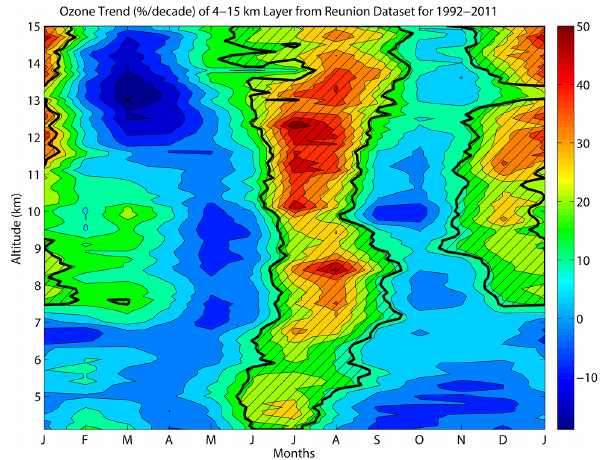
Figure 8. Same as Fig. 7 except trend in Réunion profiles, 4–15km, from 1992 to